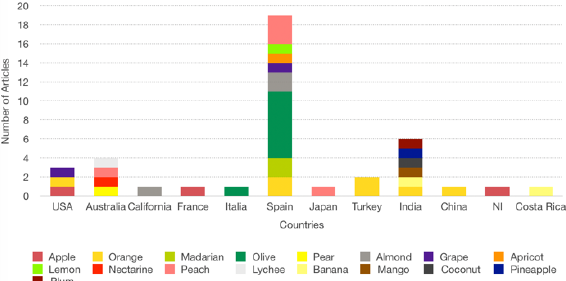
Figure 2 - Distribution of research locations and investigated